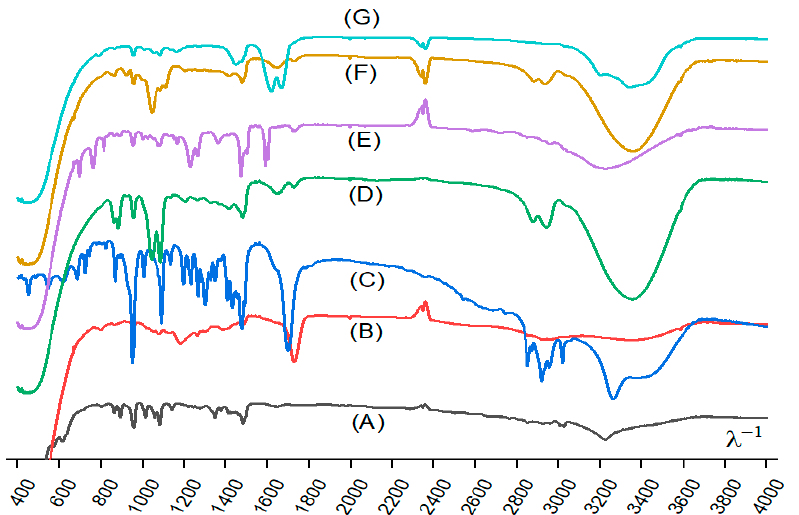
Figure 2. FTIR spectra of the synthesized deep eutectic solvents. ( A ) ChCl:W; ( B ) ChCl:CA; ( C ) Figure 1. FTIR spectra of the synthesized deep eutectic solvents. ( A ) ChCl:W; ( B )